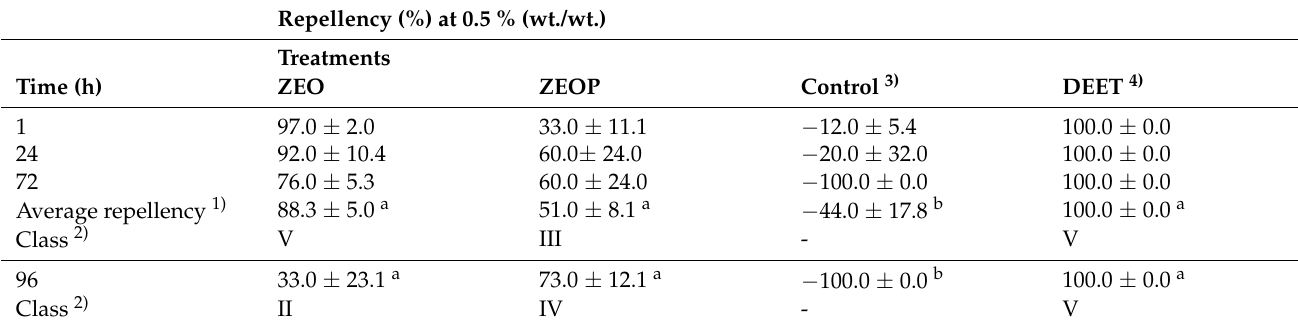
Table 3. Repellent activity of ZEO, and ZEOP against T. infestans nymphs fifth instars (mean ± SD, n = 5) at 0.5% (wt./wt.).